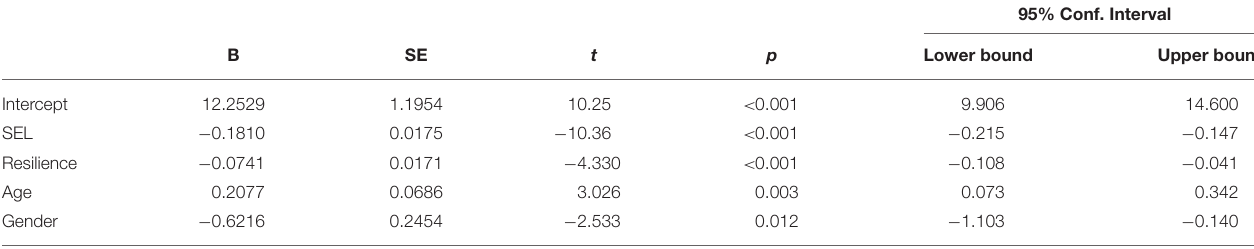
TABLE 3 | Regression outcomes for the target variable Externalizing problems.